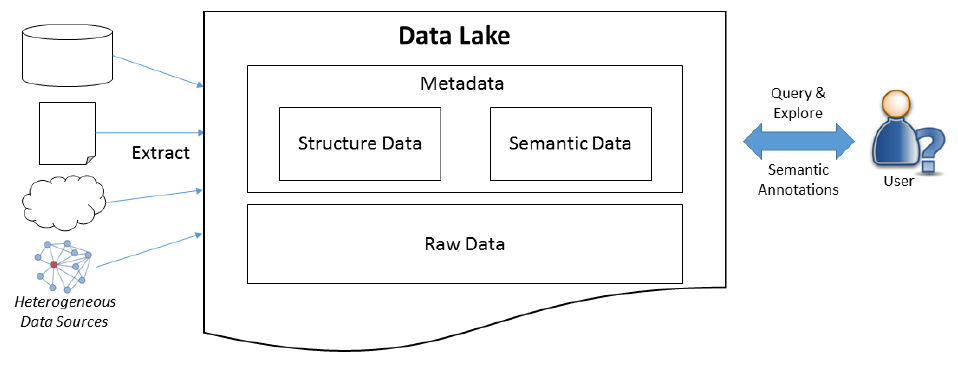
Figure 2. System